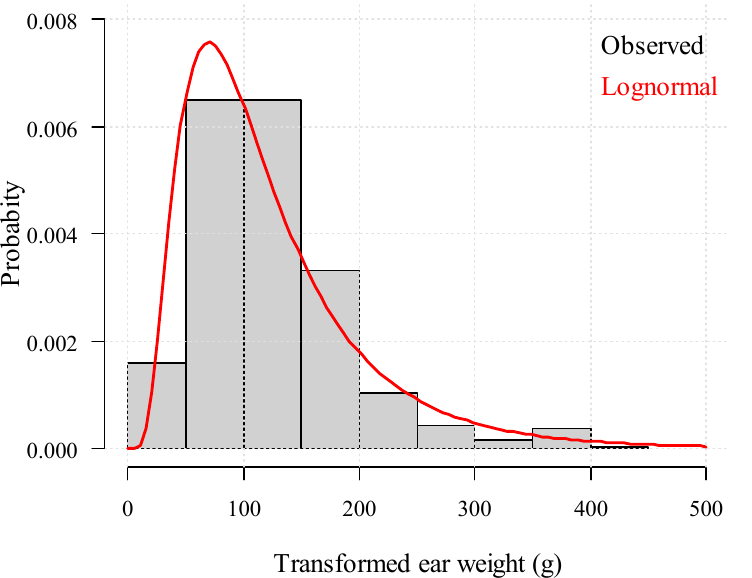
Figure 5. Ear weight distribution within the study area, 2017.